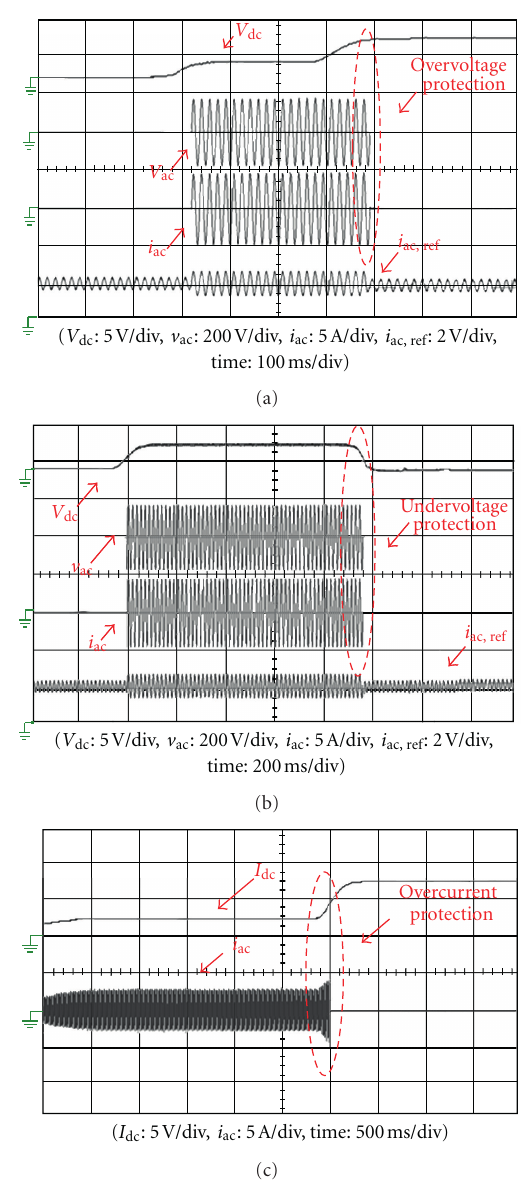
Figure 17: Measured waveforms for circuit protection functions: (a) over-voltage protection, (b) under-voltage protection, and (c) over-current